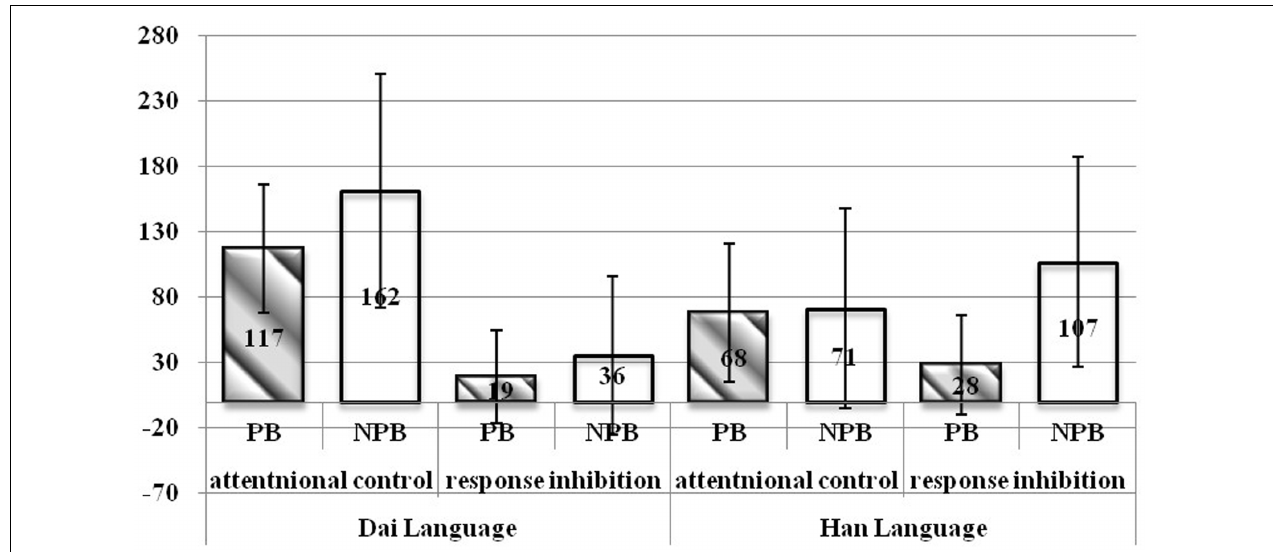
FIGURE 2 | Mean effect of different inhibitory control stages. Effect of attention control = RTSI–RTSC and effect of response inhibition = RTRI–RTRC (Kornblum and Lee, 1995). SI, stimulus inconsistent; SC, stimulus consistent; RI, response inconsistent; and RC, response